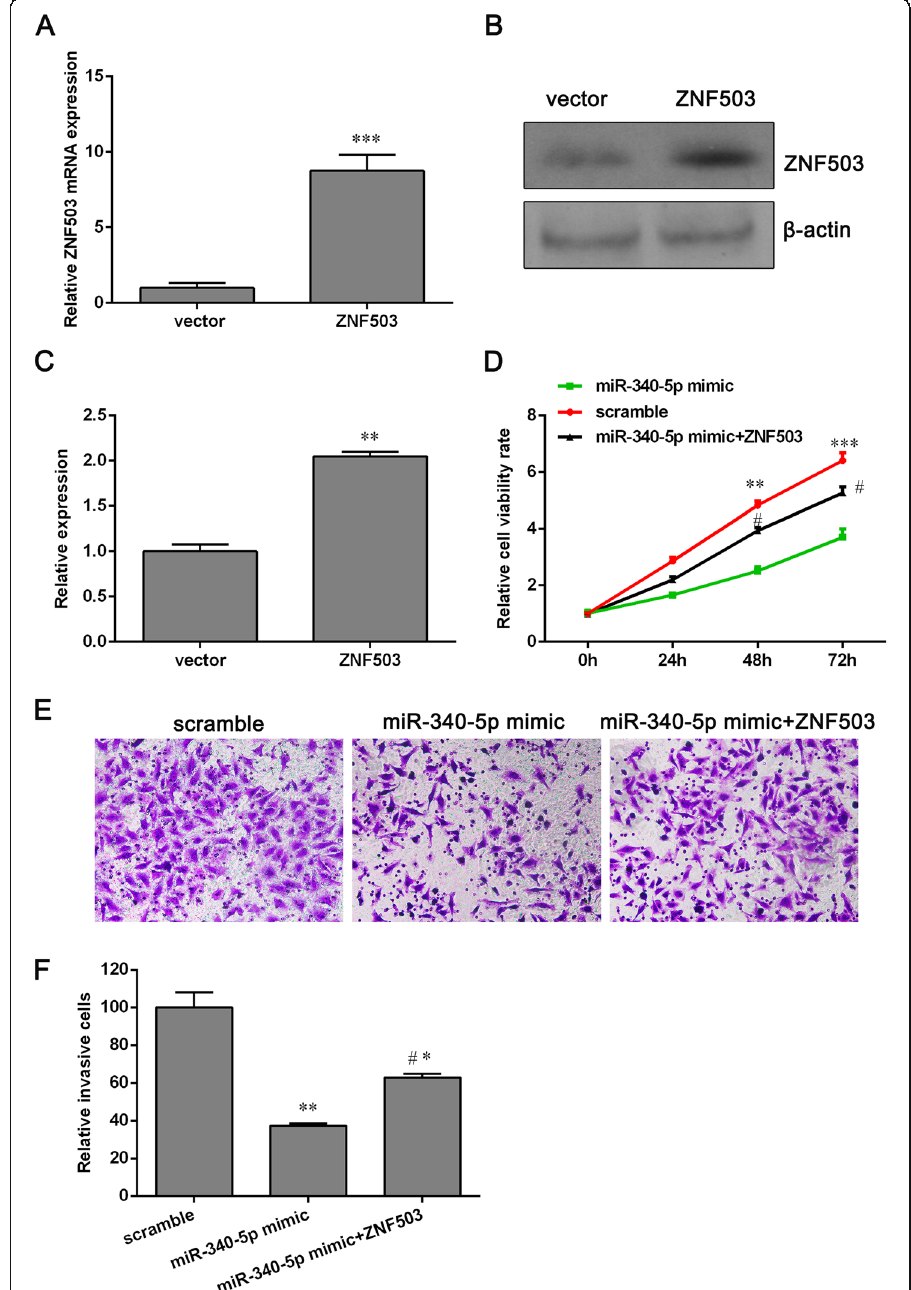
Fig. 4 Overexpression of ZNF503 reverses the inhibition of NCI-H1650 cell proliferation and invasion by miR-340-5p. a and b The mRNA ( a ) and protein ( b ) levels of ZNF503 in NCI-H1650 cells that were transfected with ZNF503 plasmids or vectors were respectively analyzed using qPCR or western blotting. c The data demonstrate relative protein expression. d The cell viability of miR-340-5p-overexpressing NCI- H1650 cells was partially elevated after overexpression of ZNF503. e Ectopic expression of ZNF503 facilitated cell invasion in NCI-H1650 cells that overexpress miR-340-5p. f The relative number of invasive cells is shown. Data are presented as the means ± SD ( n = 3). * p < 0.05, ** p < 0.01 and *** p < 0.001 versus the vector group or the scrambled group. # p < 0.05 versus the miR-340-5p mimic